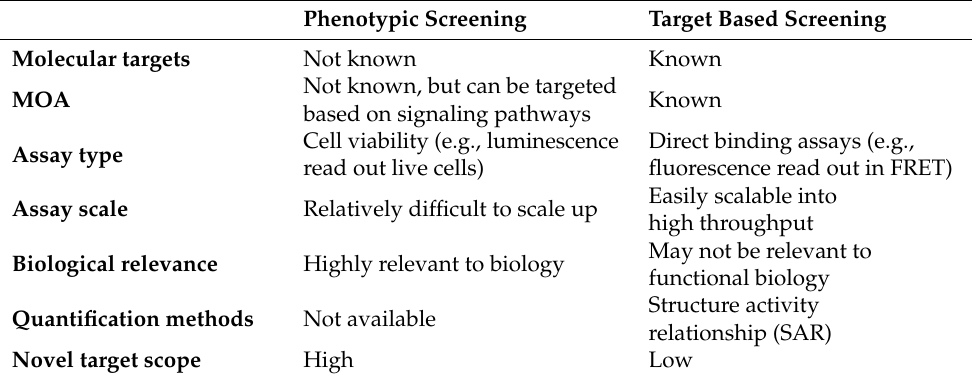
Table 1. Comparison between phenotypic and target-based